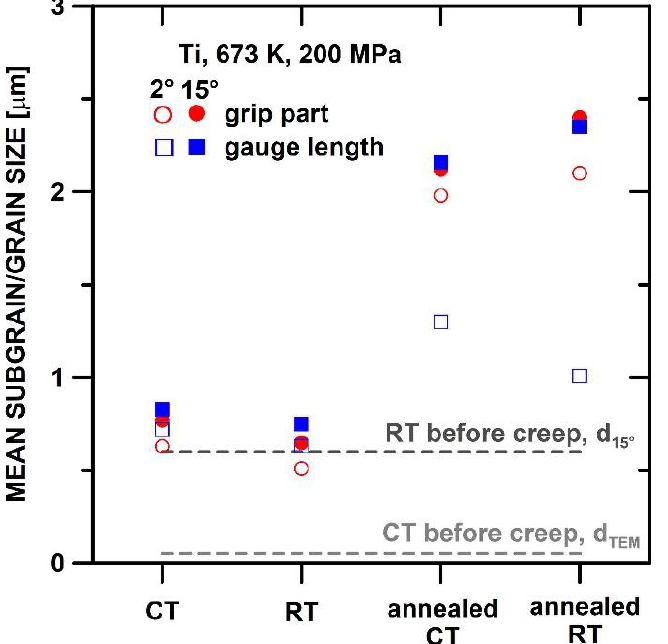
Figure 7. Microstructure of annealed CT state after creep testing at 200 MPa and 673 K: ( a ) grip part, ( b ) gauge length, and ( c ) misorientation distributions.